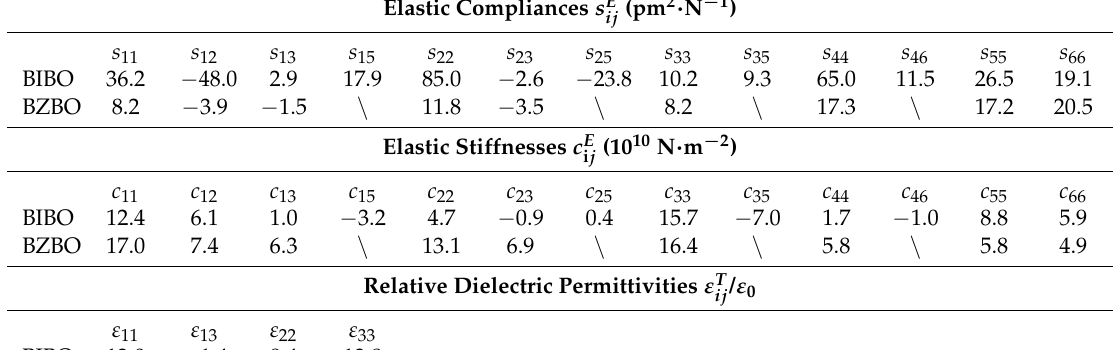
Table 2. The electro-elastic constants of α -BIBO and BZBO crystals measured at room temperature [18,21].